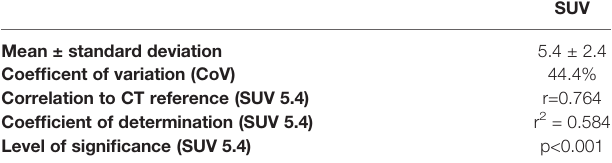
TABLE 5 | Individual backwards